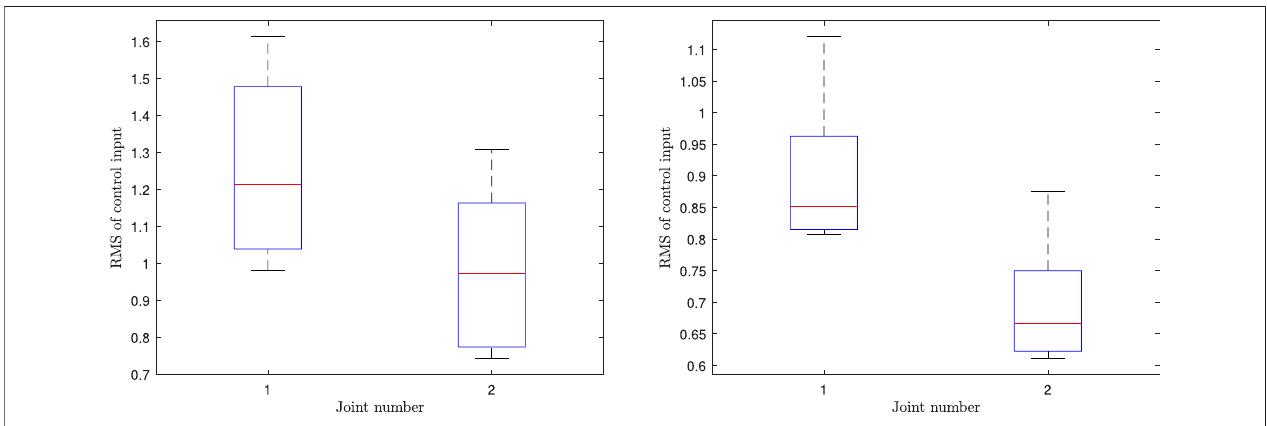
FIGURE 9 | The RMS values of control inputs corresponding to the CLF/CBF-based ProMP controller for the fourth scenario (left) and the fi fth scenario (right).